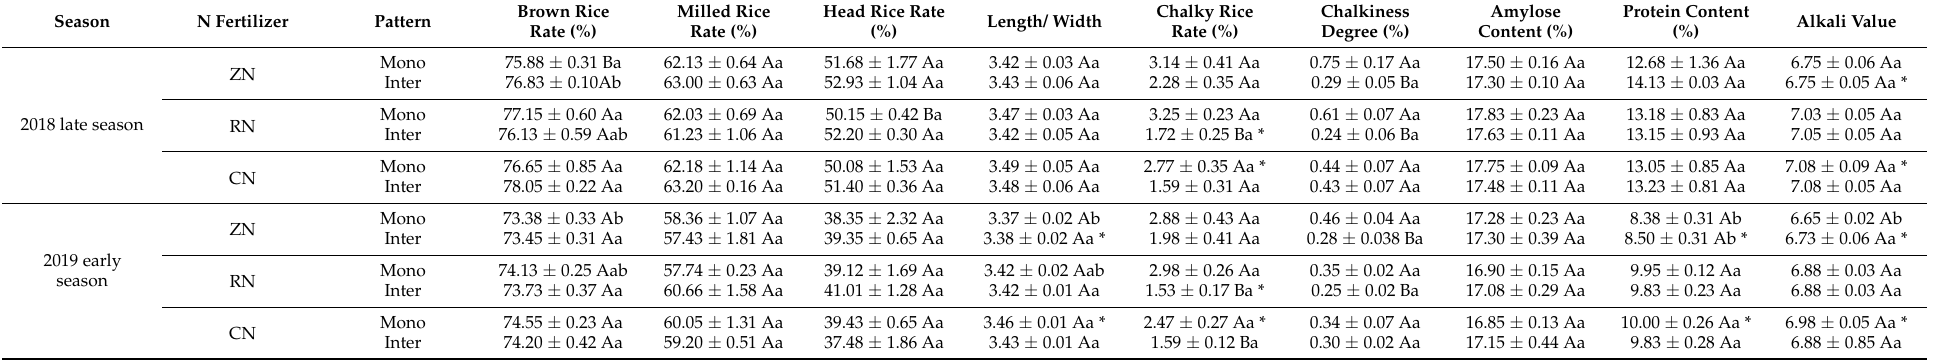
Table 2. Grain quality of rice in monocropping and intercropping treatments with the three different N fertilizer application